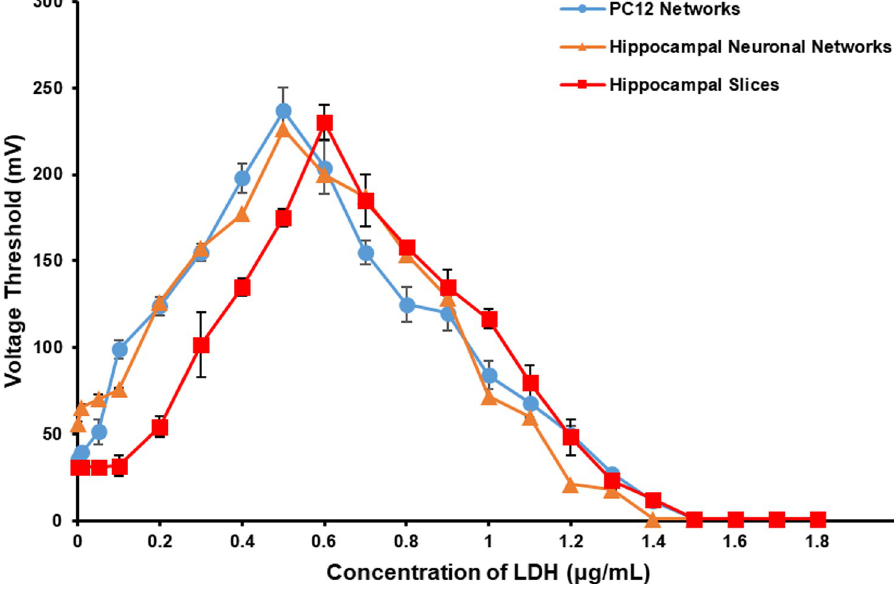
Fig 10. The V Th of the three types of neuronal networks under the effect of LDH in different concentrations ( n = 5 for PC12 networks, n = 4 for hippocampal neuronal networks and hippocampal slices).